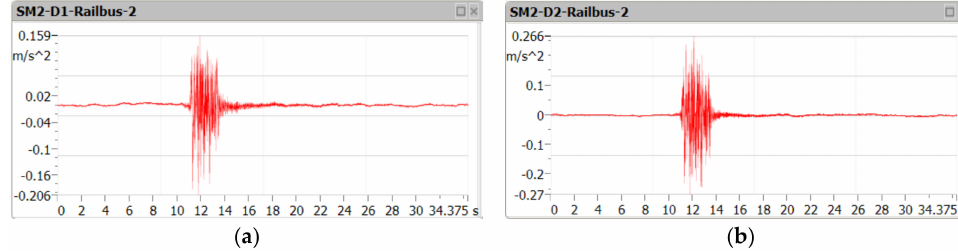
Figure 6. Amplitude of vertical vibration acceleration during the passage of the railbus at the speed of 115 km/h, in the deck slab ( a ) and the bottom flange of the girder ( b ).